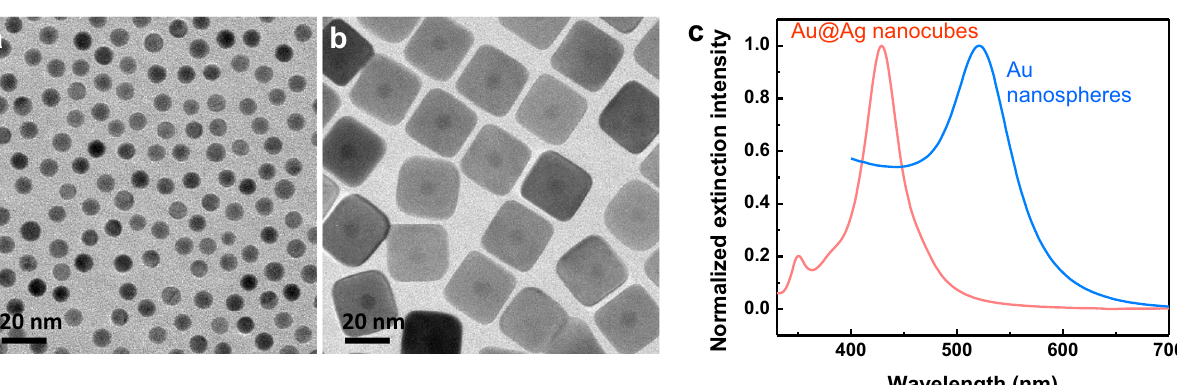
Figure 2. ( a ) TEM image of Au nanospheres. ( b ) TEM image of Au@Ag nanocubes. ( c ) Representative UV–Vis extinction spectra of the aqueous suspensions of Au nanospheres and Au@Ag